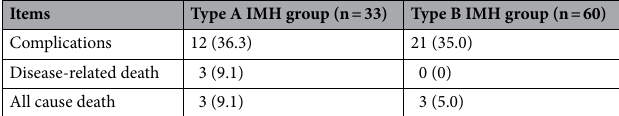
Table 12. Follow-up of conservative treatment patients [example (%)].